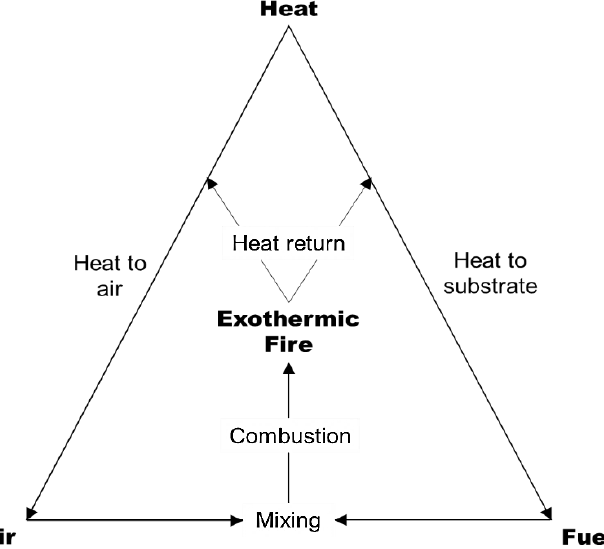
Figure 2. Emman’s fire triangle demonstrates the elements for a sustained flame.